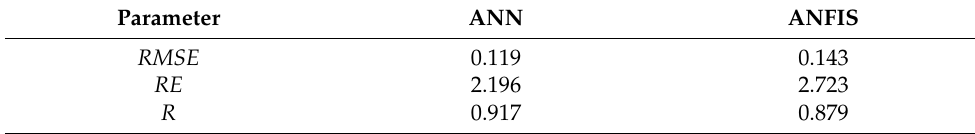
Table 3. Regression architecture